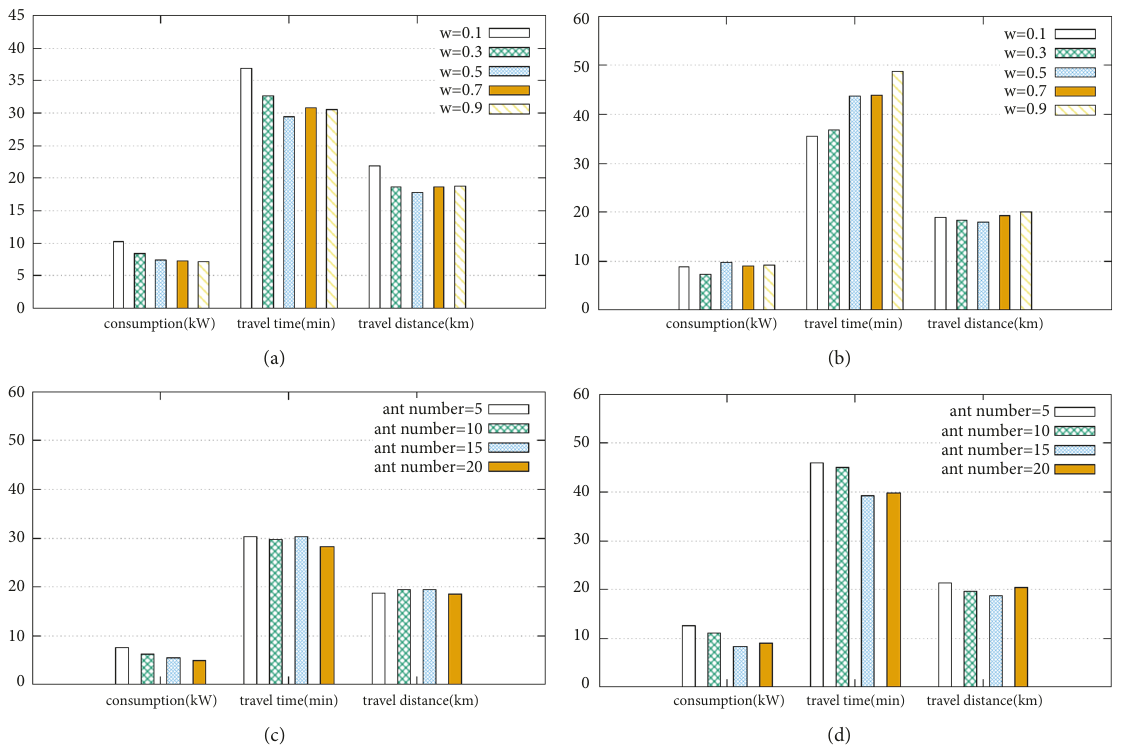
Figure 3: Performance comparison with varying weight and number of ants: (a) varying weight with Gaussian distribution, (b) varying weightwith uniform distribution, (c) varying the numberof antswith Gaussian distribution, and (d) varying the numberof antswith uniform